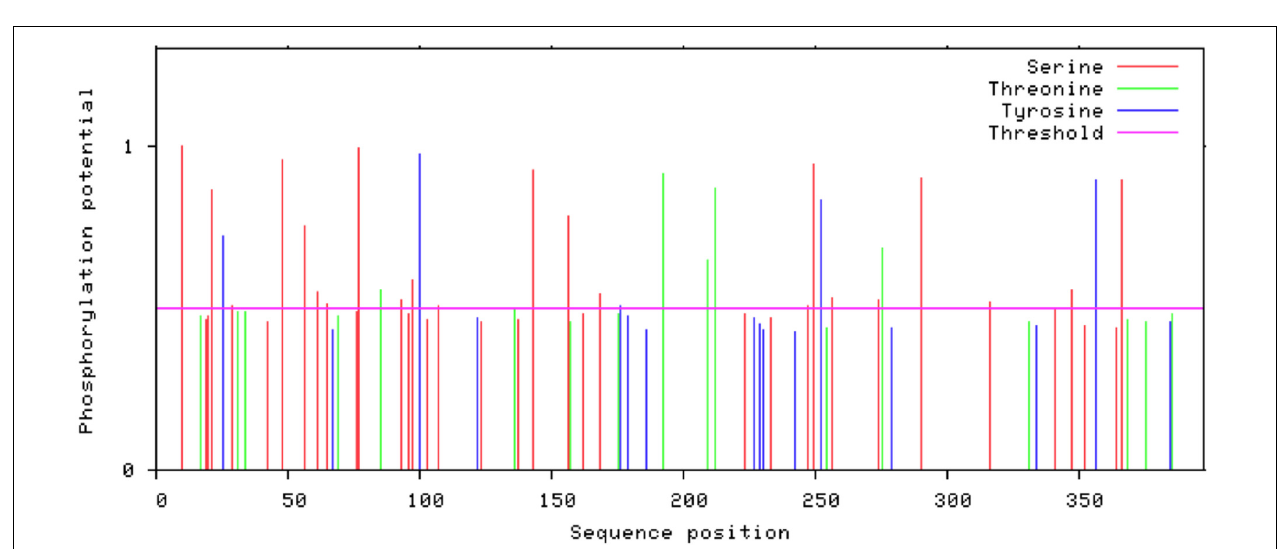
FIGURE 8 | The predicted potential phosphorylation sites in 3p.AtFBP113 sequence. Several residues with high potential for phosphorylation were predicted by the NetPhos server as indicated by their high score in the graph. The higher score, i.e., 1 demonstrates high confidence in the prediction. Among these, serine residues seem to have more potential for phosphorylation as many serine residues have a score near 1.